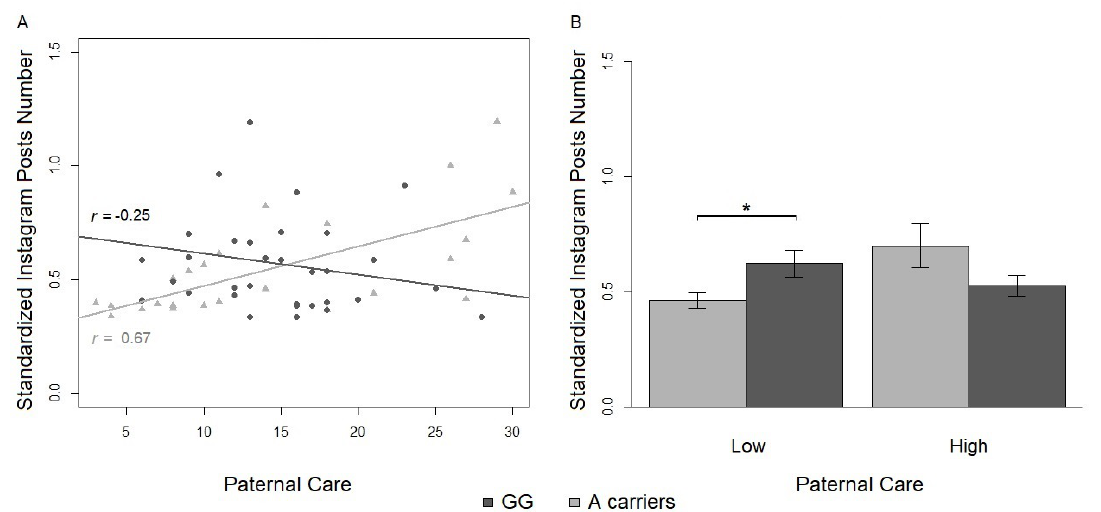
Figure 2. ( A ) Effect of the interaction between paternal care and genotype on the standardized number of Instagram posts. Correlations between the number of Instagram posts and the reported paternal care. Black circles = G/G homozygotes; grey triangles = A-carriers. Lines constitute the linear models for G/G homozygotes (black) and A-carriers (grey). r -values refer to Pearson’s r correlations. ( B ) Comparison between the number of Instagram posts in G/G homozygotes (black) and A-carriers (grey) divided into high and low paternal care (* p <